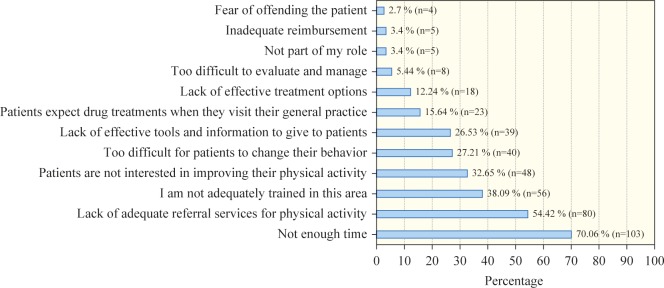
Percentage of perceived barriers to providing physical activity counseling from the physicians’ perspective.